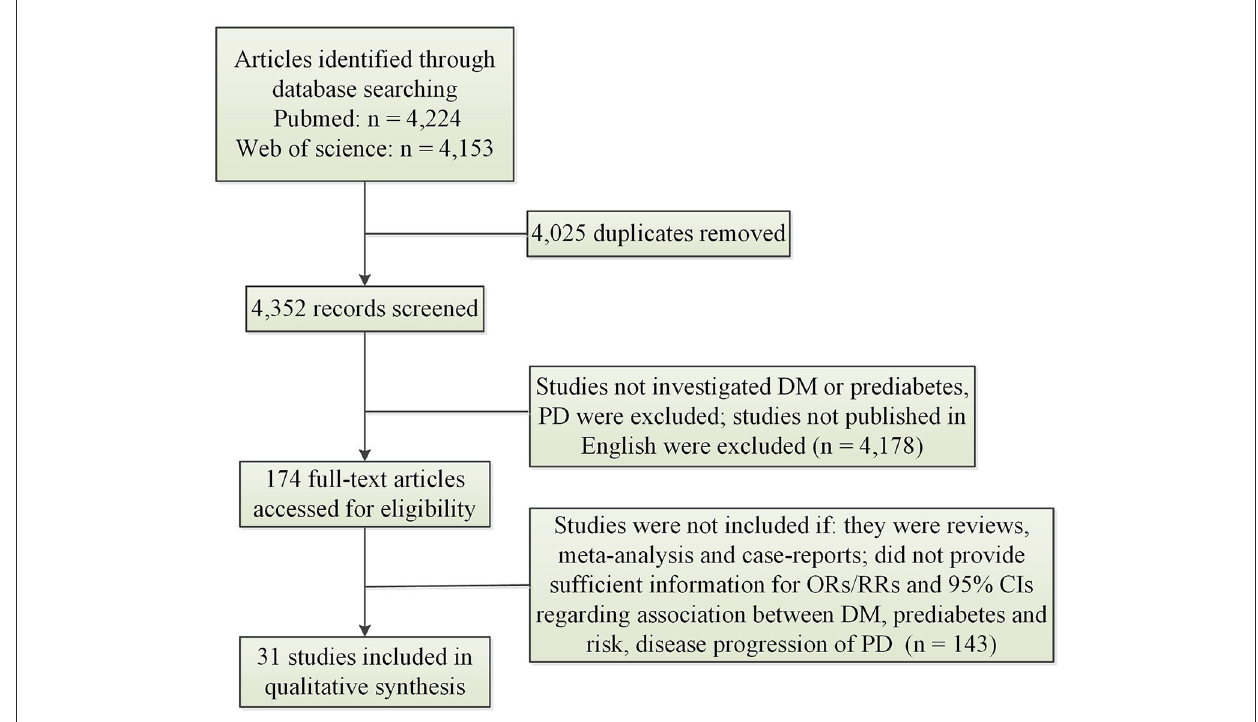
FIGURE1 Search results and selection process. CI, confidence interval; DM, diabetes mellitus; OR, odds ratio; PD, Parkinson’s disease; RR, relative